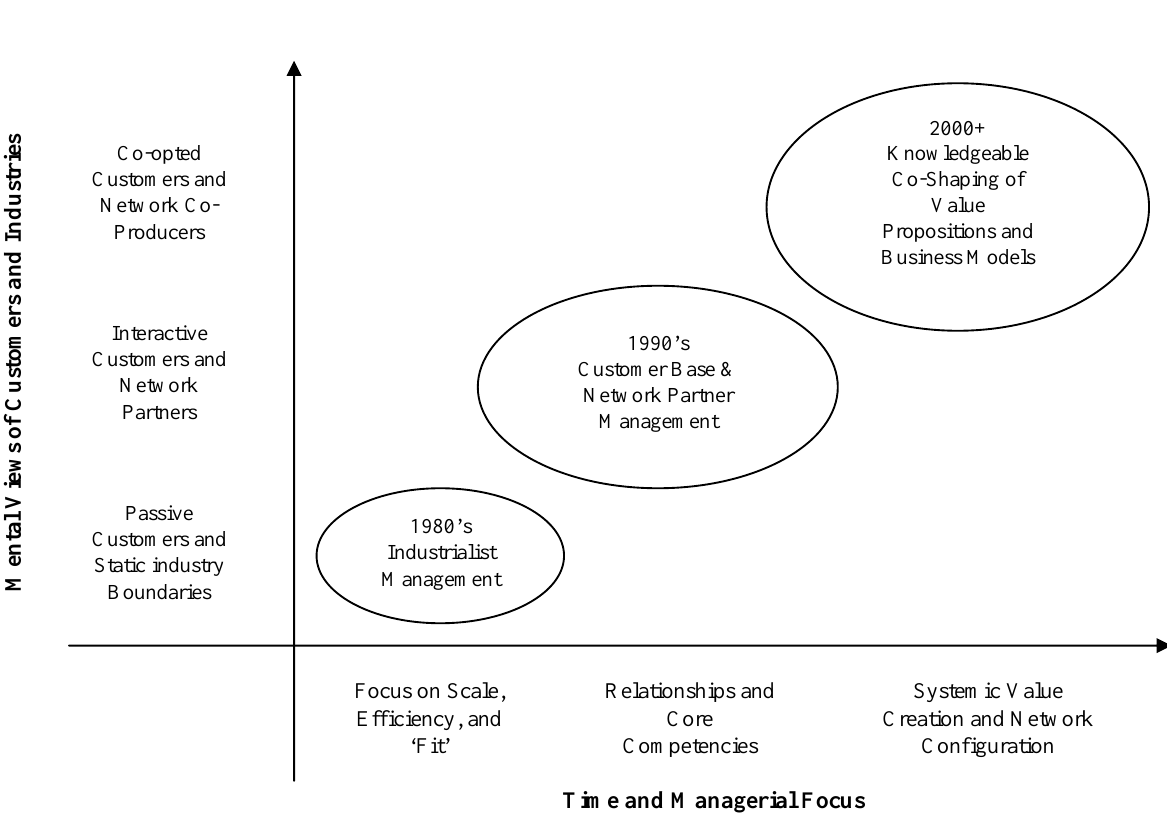
Figure 1: Evolution of mental views of customers and industries, 1980s to